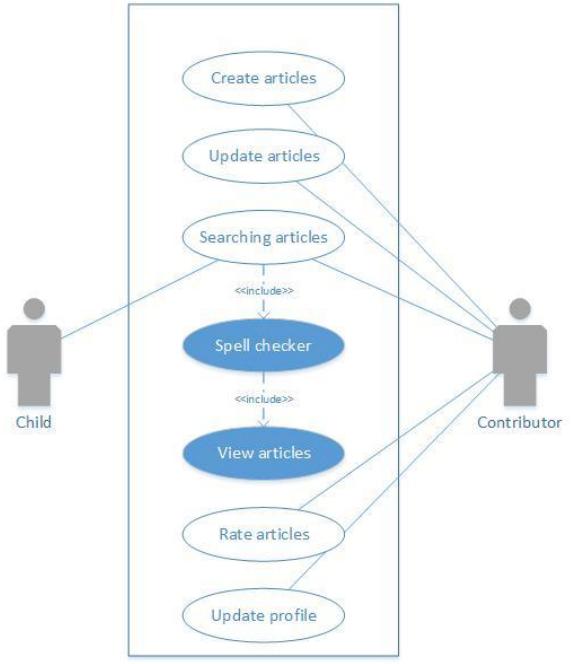
Fig. 2 Use case diagram of an app